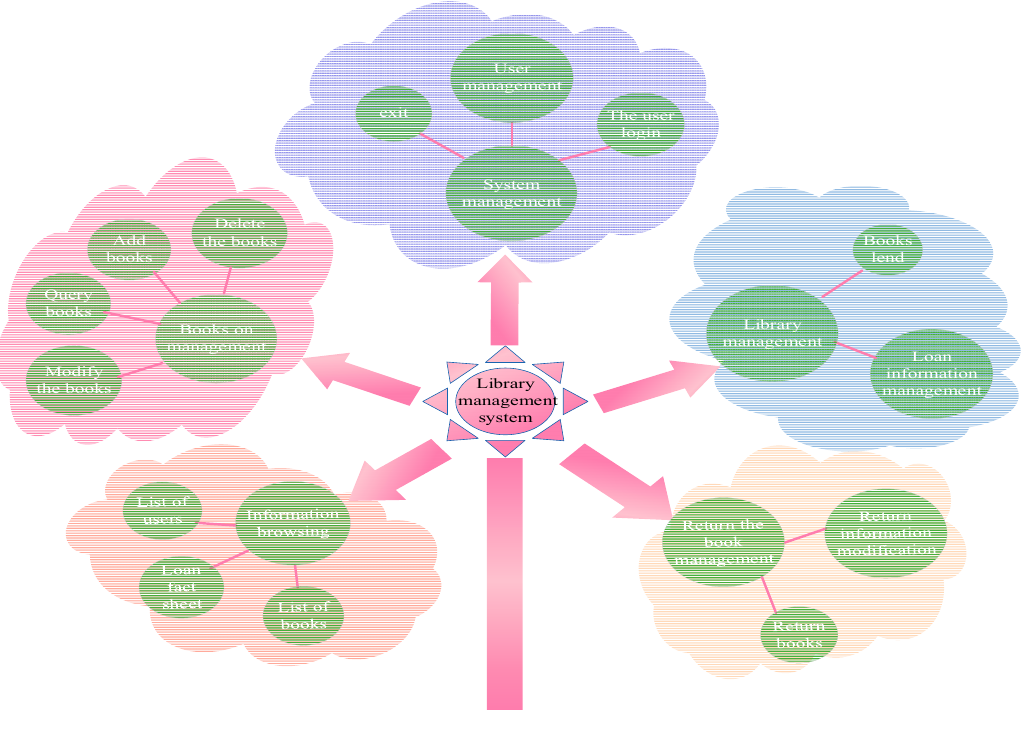
Figure 2. Library management system level module.